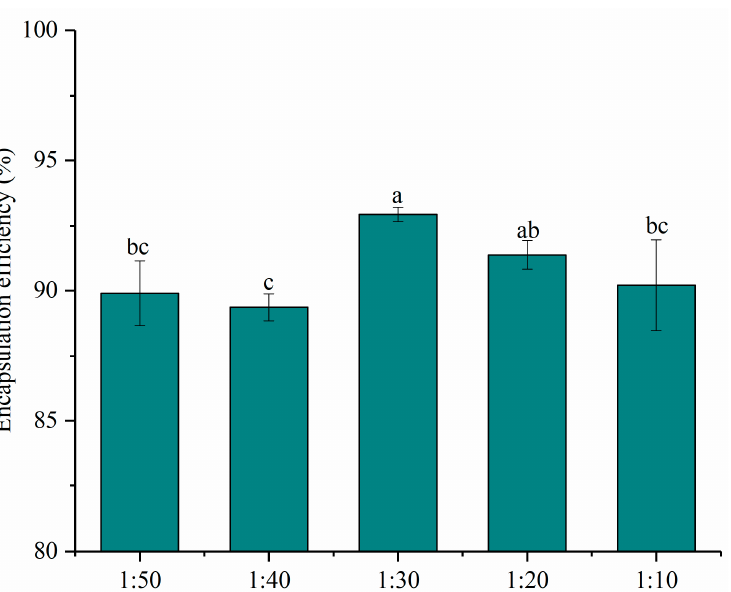
Figure 1. Encapsulation efficiency of nanoparticles at different PNS-PWP mass ratios of 1:50, 1:40, 1:30, 1:20 and 1:10 ( w / w ). Different subscript letters indicate a significant difference ( p < 0.05).